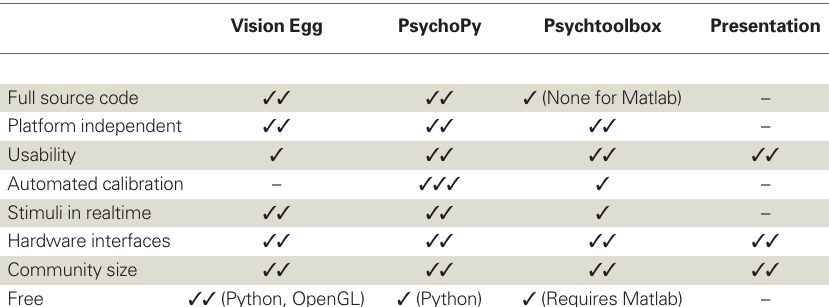
Table 1 | Comparison of several frequently used software packages for visual stimulus